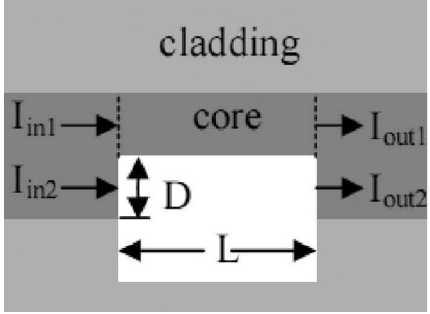
Figure 5. Schematic of the MZI structure fabricated by the use of femtosecond laser pulse irradia- tion [65]. Reprinted with permission from Ref. [65]. Copyright 2010 Optica Society.